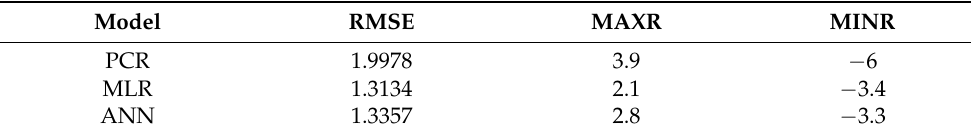
Figure 14. Residual error in experiment I: ( a ) residual error of PCR model; ( b ) residual error of MLR model; ( c ) residual error of ANN model. Table 20. Fitting results of three models.